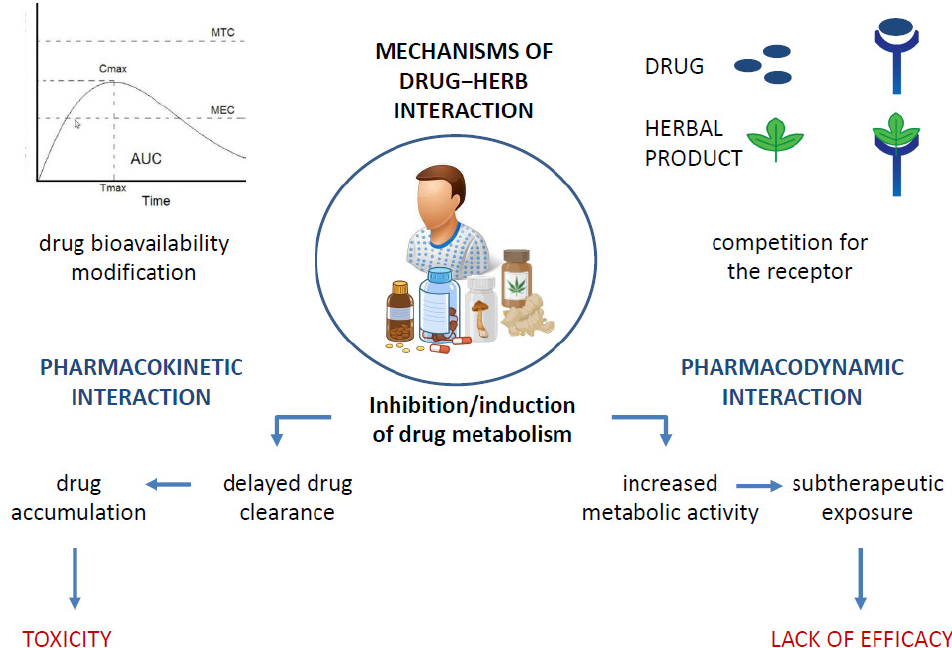
Figure 2. Possible mechanisms of drug − herb interactions, leading to toxicity development or lack of drug efficacy.